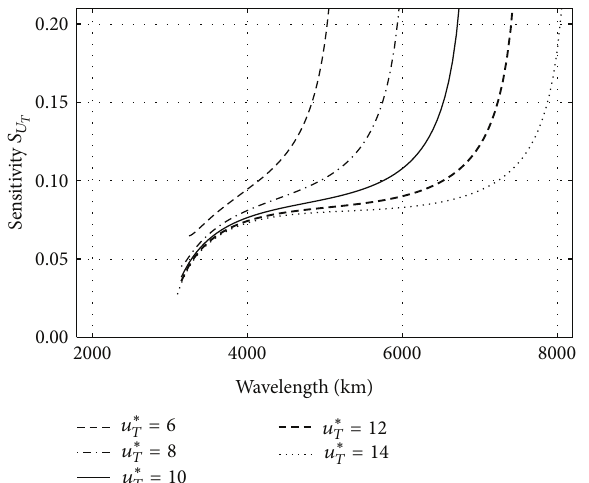
Figure 5: Sensitivity coefficients 𝑆 𝑢 versus the wavelength for different reference values of thermal wind 𝑢 ∗ 𝑇 for the case of 𝜎 = 2 × 𝑇 10 −6 m 2 ⋅ Pa −2 ⋅ s −2 .